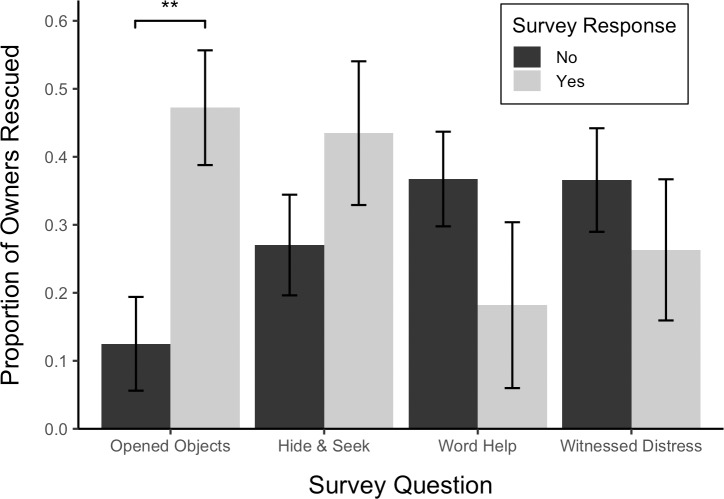
Proportion of owners rescued by survey response.Error bars show standard errors.